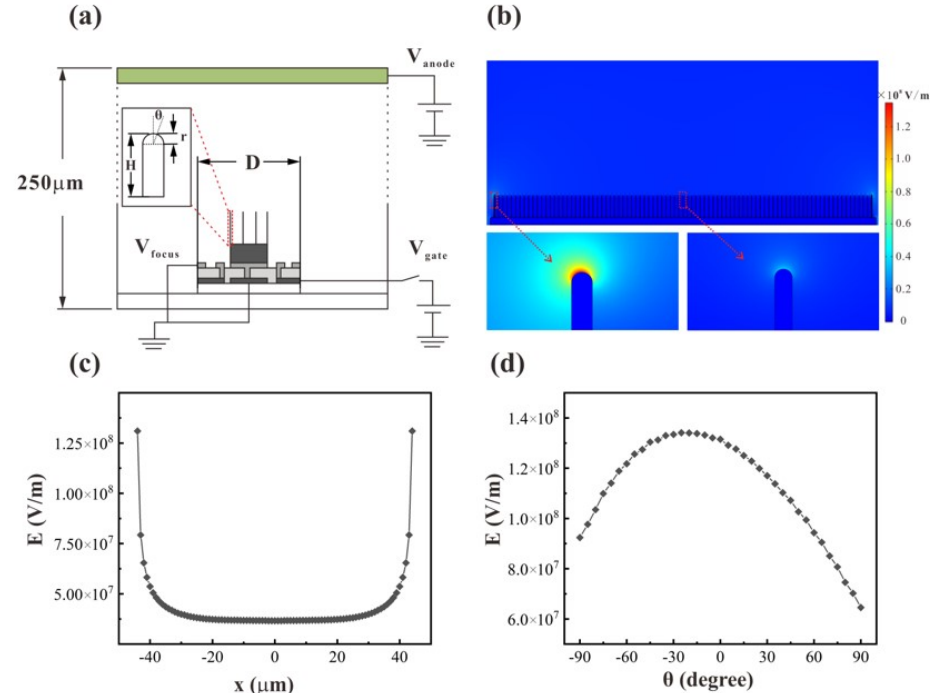
Figure 2. ( a ) Schematic of the model for simulating the electric field; ( b ) a typical simulation result with D = 250 µ m, R1 = 45 µ m, R2 = 60 µ m, R3 = 80 µ m, R4 = 105 µ m, H = 4 µ m, r = 25 nm, h = 0.3 µ m, V gate = 150 V; ( c ) electric field at the tip of nanowires in a pixel obtained from ( b ); ( d ) typical electric field at different angles of the nanowire